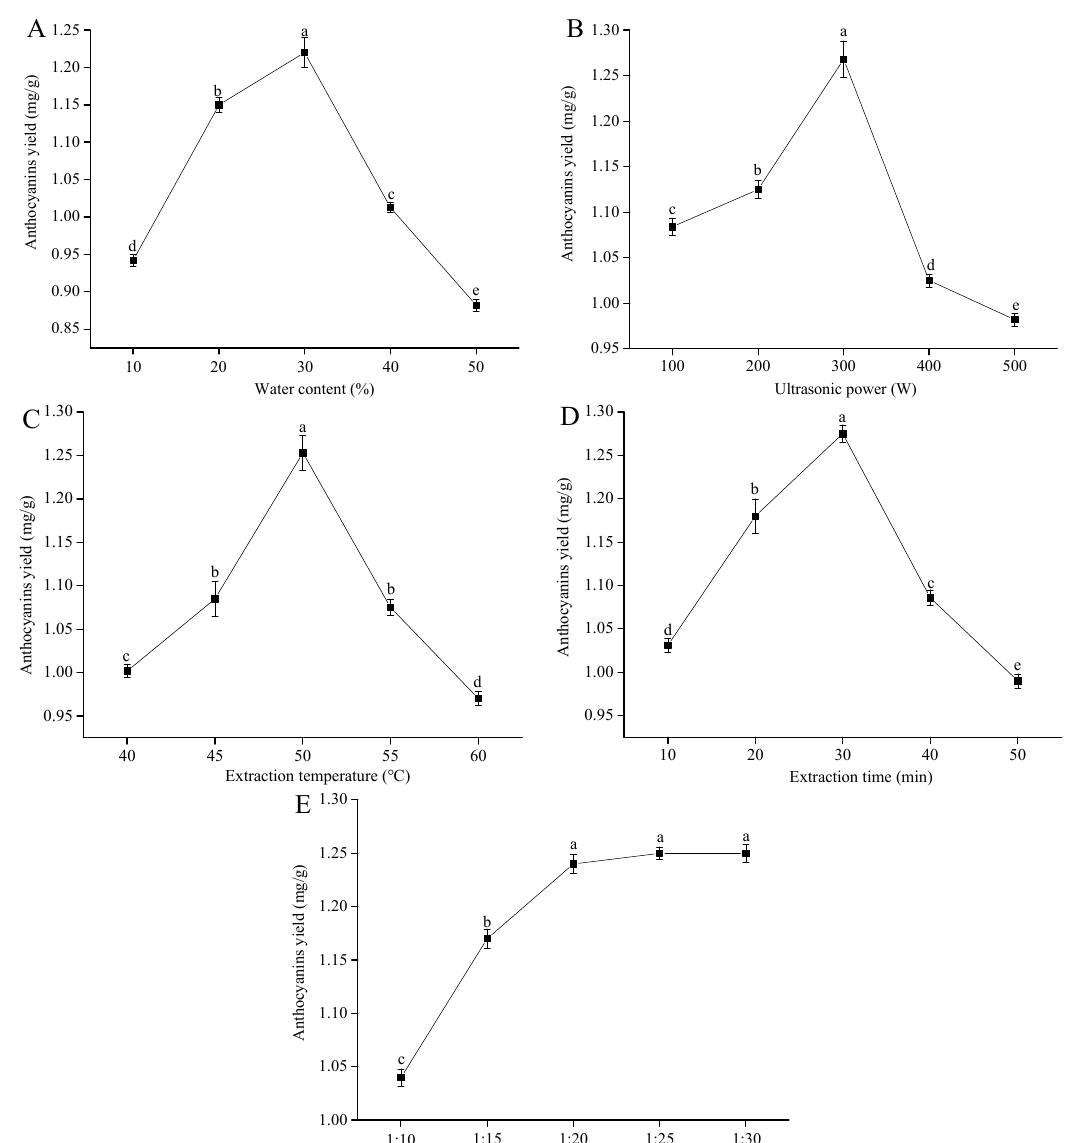
Figure 2. Effects of different extraction variables on the anthocyanin yields from raspberries. ( A ) Water content, ( B ) ultrasonic power, ( C ) extraction temperature, ( D ) extraction time and ( E ) solid-to-liquid ratio. Note: The different lower-case letters indicate significant differences ( p < 0.05; the same below).